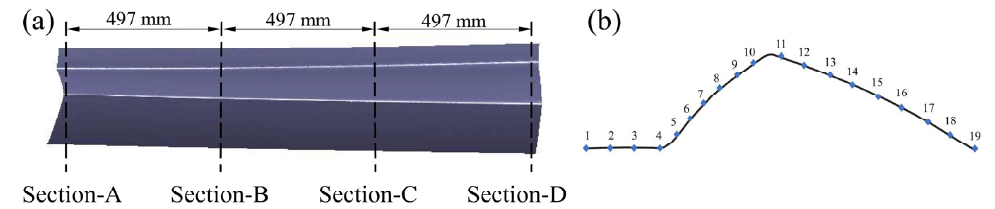
Figure 13. ( a ) Thickness detection sections. ( b ) The positions of the measurement points in each section.